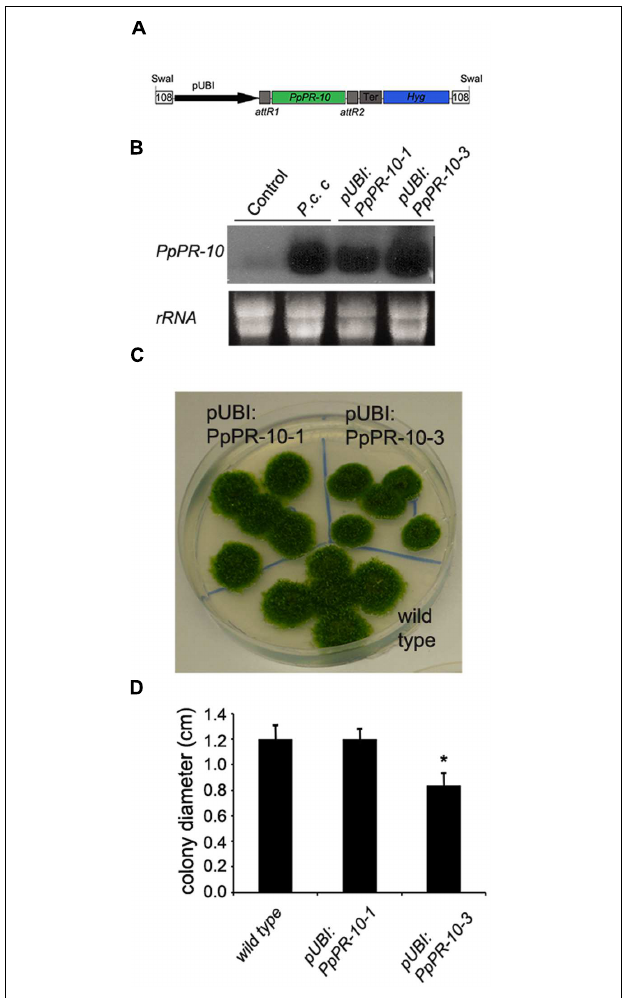
FIGURE 4 | Generation of PpPR-10 overexpression P. patens plants. (A) Schematic representation of PpPR-10 overexpressing construct using plasmid pTHUbi. (B) Transcript levels of PpPR-10 in untreated (Control) and Pectobacterium corotovorum subsp. carotovorum ( P.c. c ) elicitor-treated wild type plants, and untreated pUBI:PpPR-10 overexpressing lines. (C) Phenotype of wild type, pUBI:PpPR-10-1, and pUBI:PpPR-10-3 moss colonies. (D) Size of wild-type, pUBI:PpPR-10-1, and pUBI:PpPR-10-3 moss colonies grown for 21 days in BCDAT medium measured as diameter in centimeters. Results and standard deviation correspond to 16 colonies per sample. Asterisk for pUBI:PpPR-10-3 colonies indicates that the values are significantly different from wild type plants according to Kruskal–Wallis test: P <